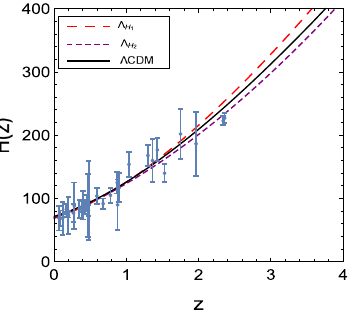
Fig. 8 Variation of the Hubble function as a function of the redshift z for the best-fit value of the models using Ds2 data set. The observational 36 H ( z ) points are shown with error bars (grey colour). The variation of the Hubble function in the standard Λ CDM model is also represented as the solid